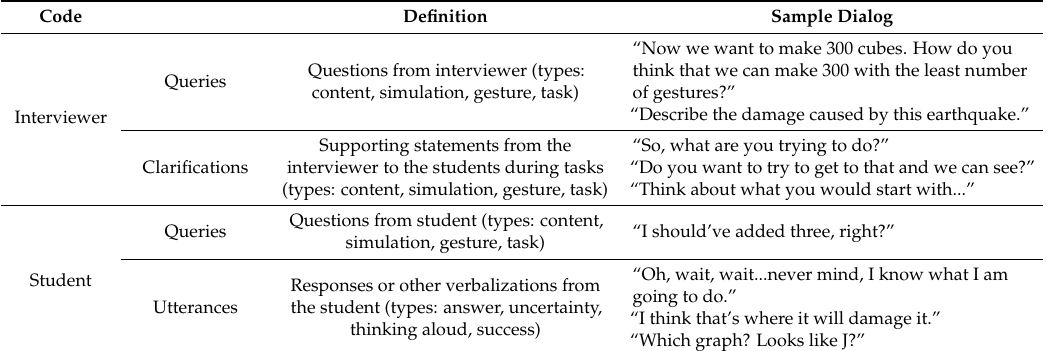
Table 1. Coding scheme and sample code dialog.